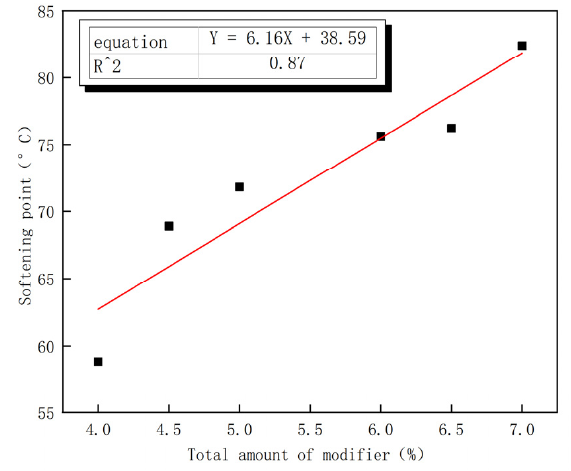
Figure 5. Relationship between total modifier and softening Point.